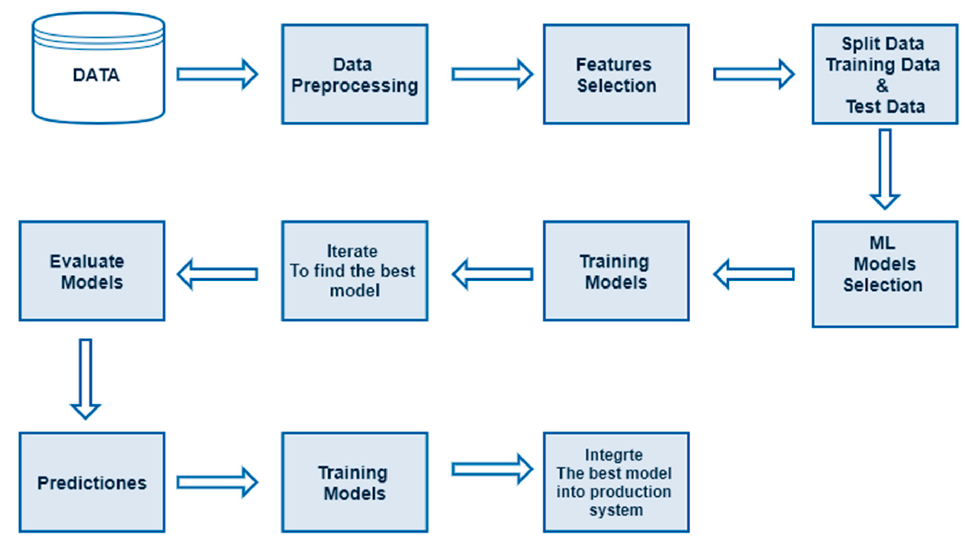
Figure 3. General workflow for ML projects.